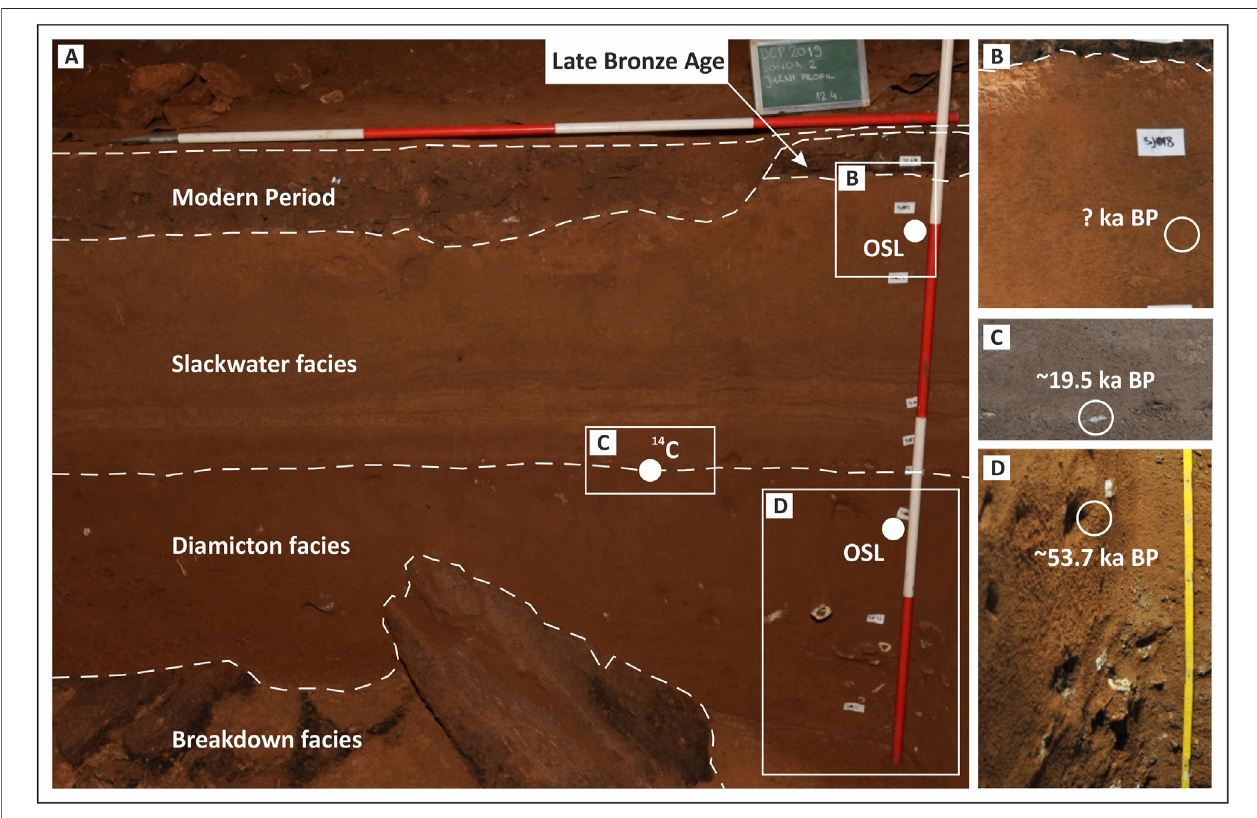
FIGURE 11 | Facies types and age on pro fi le DC-SP in the Lower Cerova ˇ cka Cave (A) Facies distribution with indicated sampling spots, (B) detailfrom upper part of Slackwater facies with indicated sampling spot and luminescence age, (C) 14 C age with indicated sampling spot within fl owstone fragment, (D) detail from diamicton facieswithvisiblelargerclastsandbonefragmentsof Ursusspelaeus withindicatedsamplingspotandluminescenceage[authorsofphotographs (A) DTP, (B) – (D) NB].